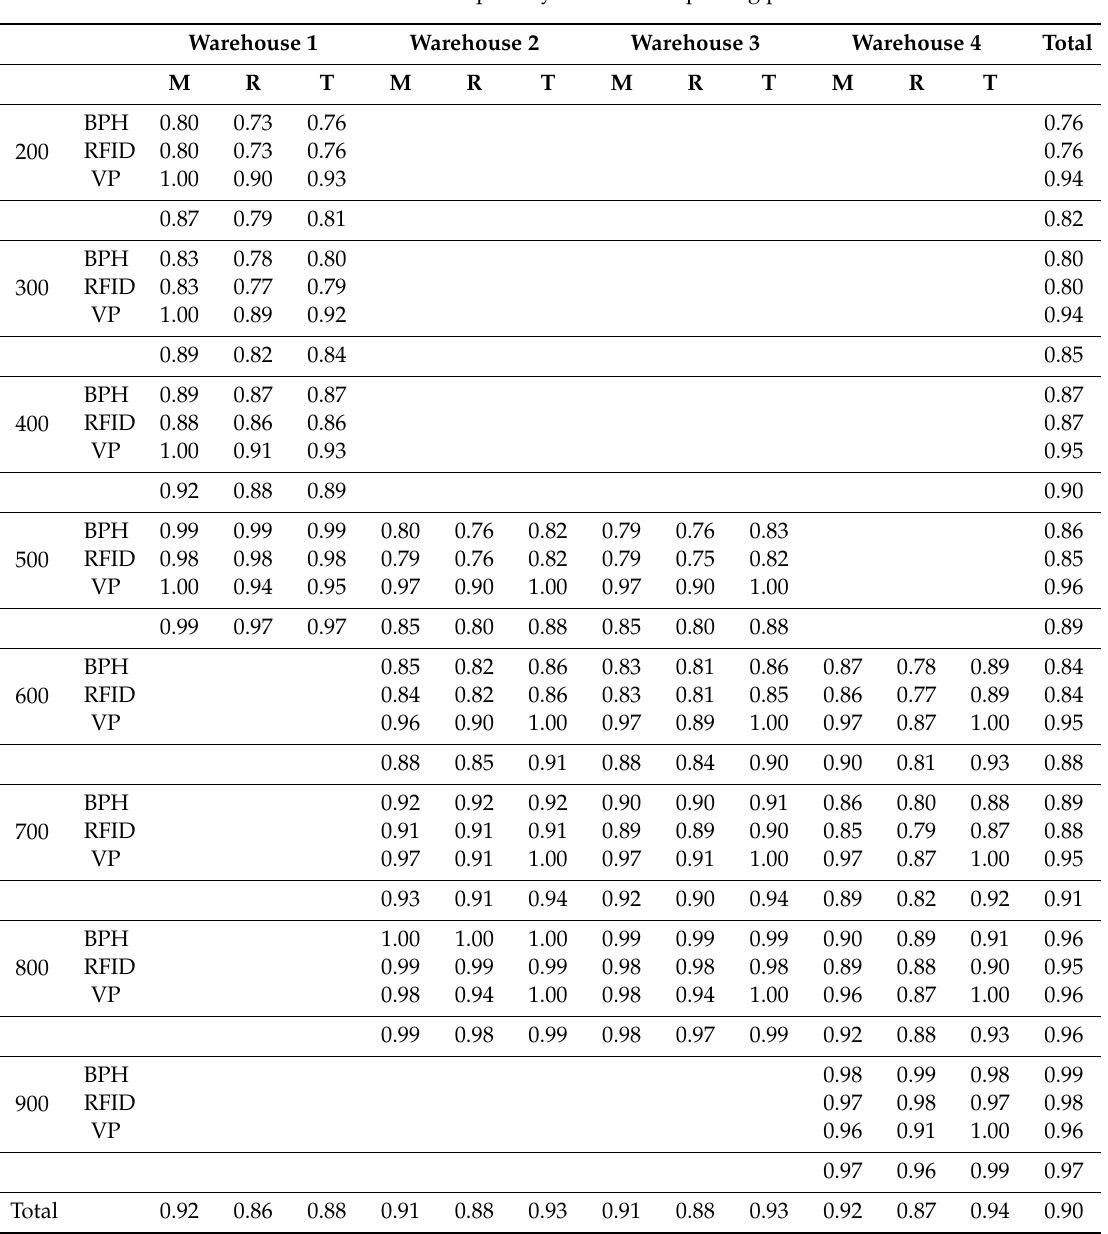
Table 8. The e ff ect of order quantity on the order picking